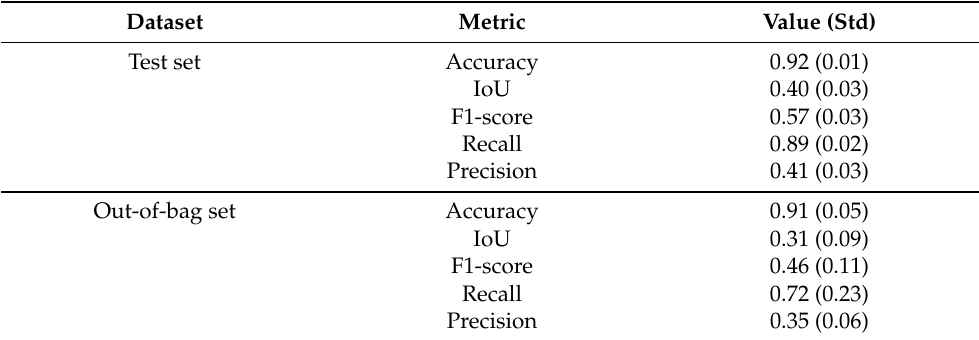
Table 1. Results shown as mean and standard deviation over all cross validation iterations for the RGB-only model.